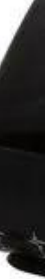
Figure 5. Maxim PPG Band.